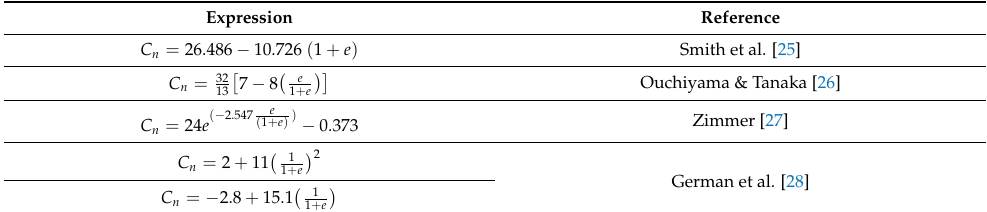
Table 2. Selected correlations between C n and e for a random assembly of